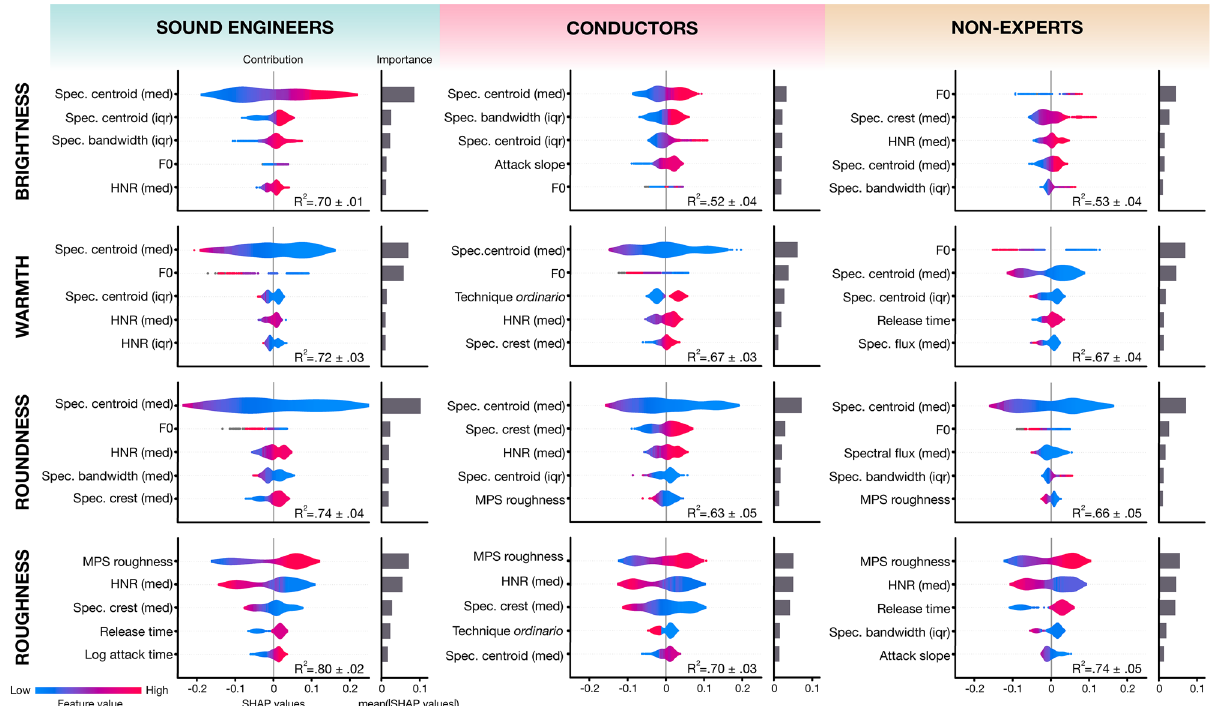
Figure 3. Top-5 features most explaining the regression model strategies for predicting the scores associated with sound concepts according to each group of participants. The figure represents both the nature of the contribution of each feature and its importance. The violin plots represent the contribution of each feature (SHAP Value on the x-axis) according to its value (hue color gradient). The thickness of the violin plot reflects the density of sounds for a feature value and contribution. The importance, i.e., the average of the absolute value of the contribution, is expressed in grey as a bar plot. med: median, iqr: interquartile